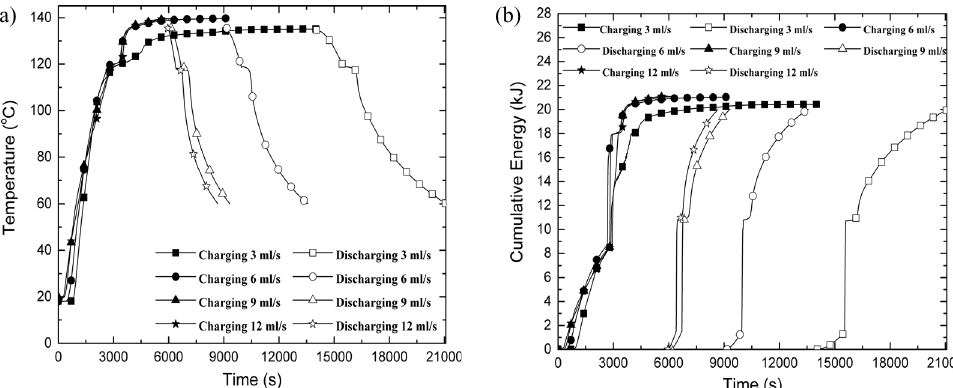
Fig. 3. (a) Average temperature histories of the EPCM during charging and discharging with the maximum heater temperature set at 150 ° C at different HTF fl ow rates. (b) The cumulative thermal energy stored and discharged by the EPCM during charging and discharging at the different HTF fl ow rates.